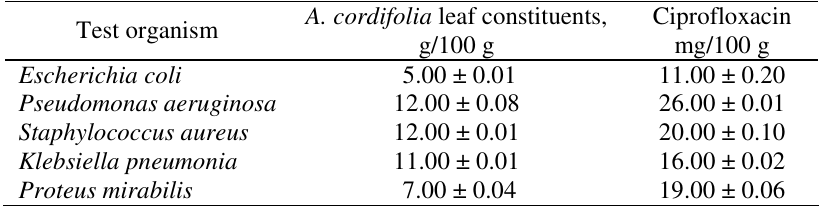
Table 2. Diameter of zones of inhibition (mm) of Compound 1 isolated from A. cordifolia leaves and ciprofloxacin